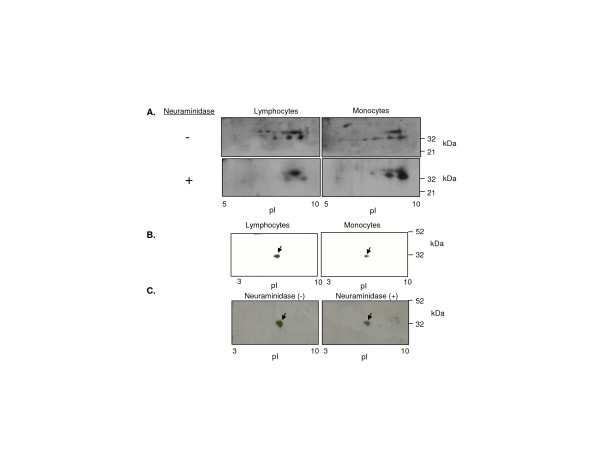
Subtle differences in CD8α between monocytes and lymphocytes detected by 2-D electrophoresis. A, Western blot with a polyclonal anti-CD8α antibody after 2-D electrophoresis of ex vivo monocytes and lymphocytes. Cell lysates of lymphocytes and monocytes from one donor were separated by adherence, halved and treated (bottom panels) or not treated (top panels) with neuraminidase before analysis. B, Western blot with anti-CD8α mAb D9. C, Neuraminidase treatment and western blot with D9 of lymphocyte lysate. Results are representative of experiments with three donors.